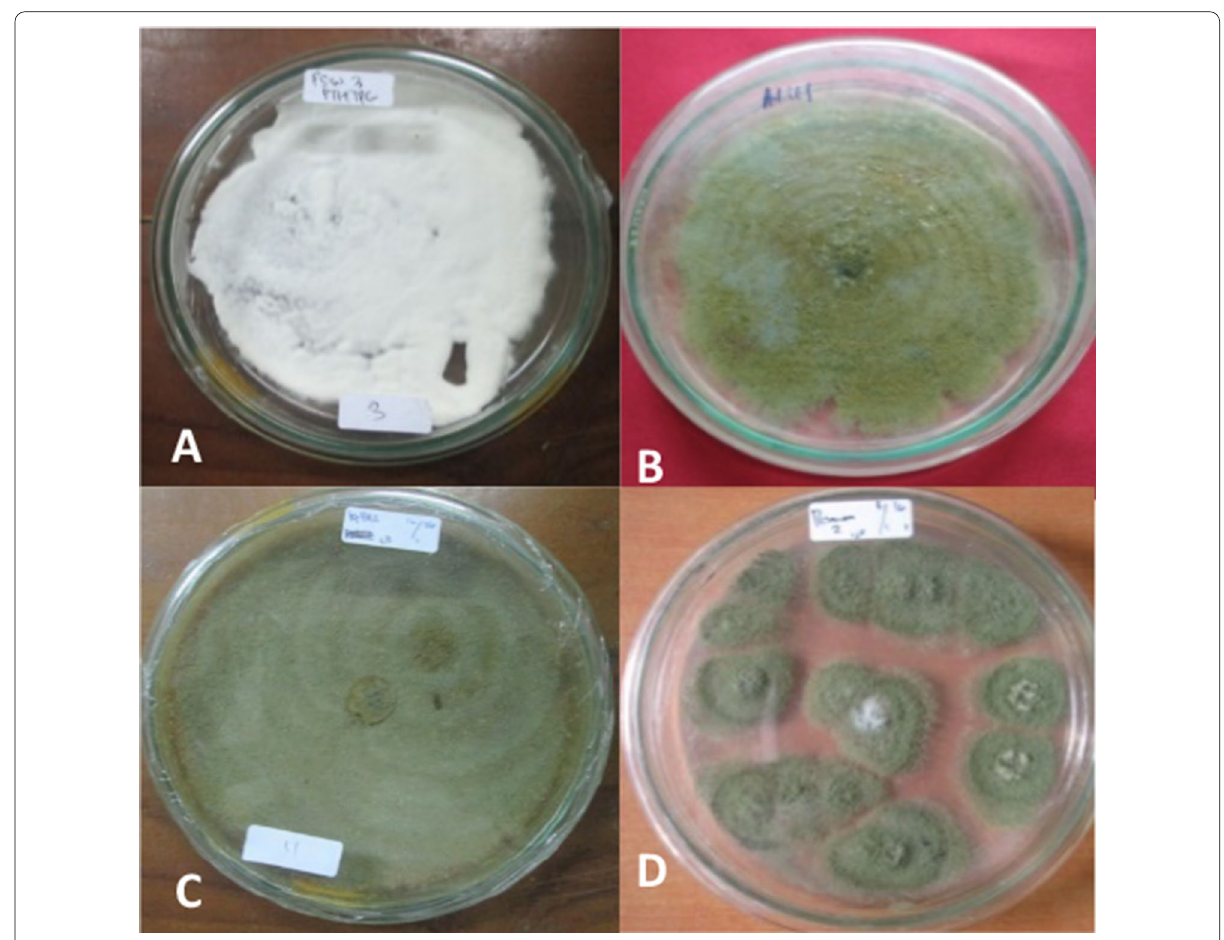
Fig. 2 Prospective fungal isolates causing death of Spodoptera litura more than 20%. a NKPT, b SKHJ, c SDHJ, d